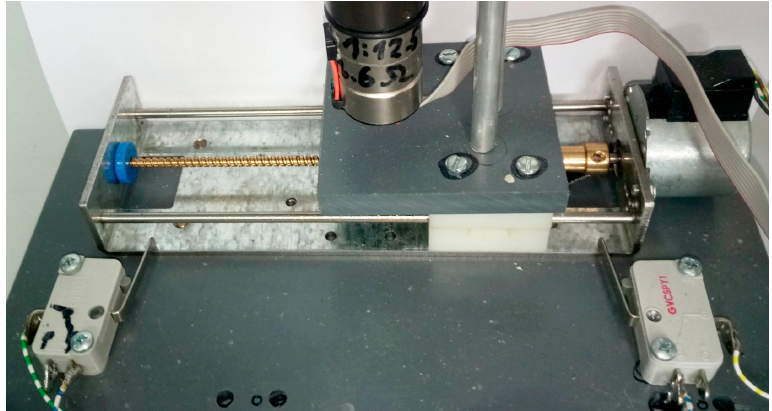
Figure 13. Translation stage with limit switches and mounted motor.